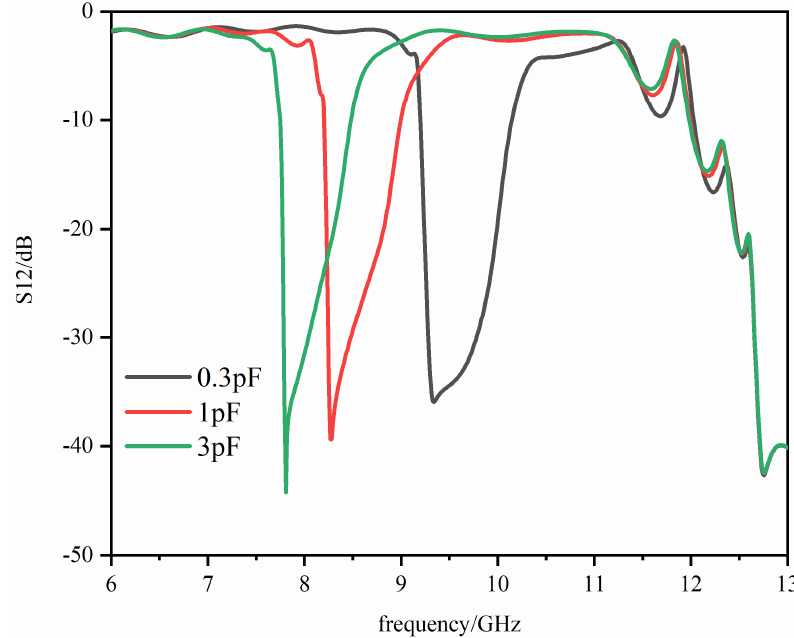
Figure 4. The simulation results of transmission coefficients under capacitances of 0.3 pF, 1 pF and 3 pF.